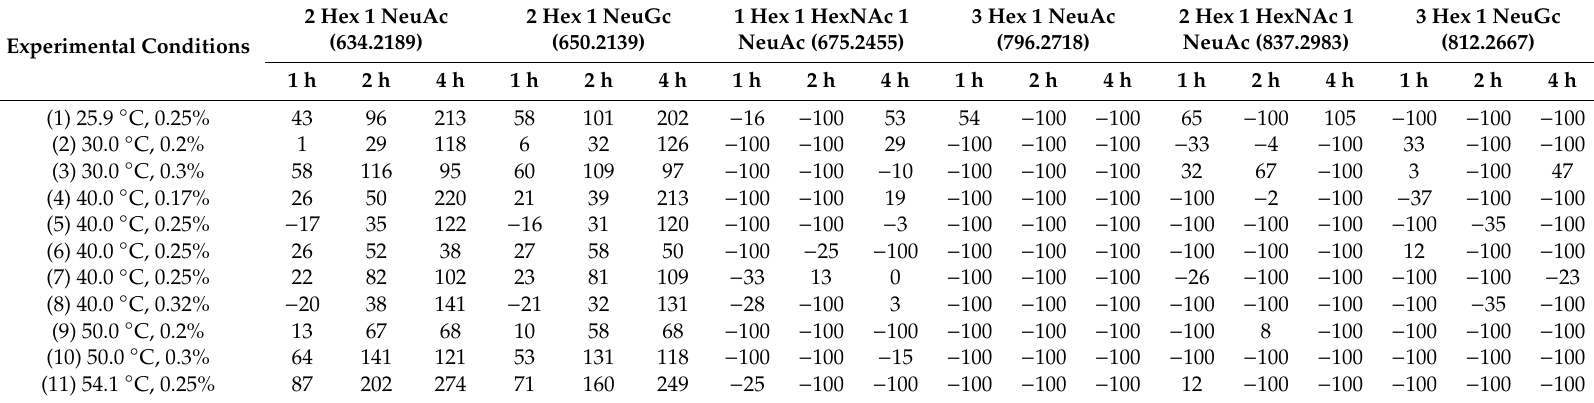
Table 2. Changes in the abundance 1 of specific acidic oligosaccharides expressed as percentage increase or decrease of oligosaccharides in the samples after treatments at 1, 2, 4 h compared to the